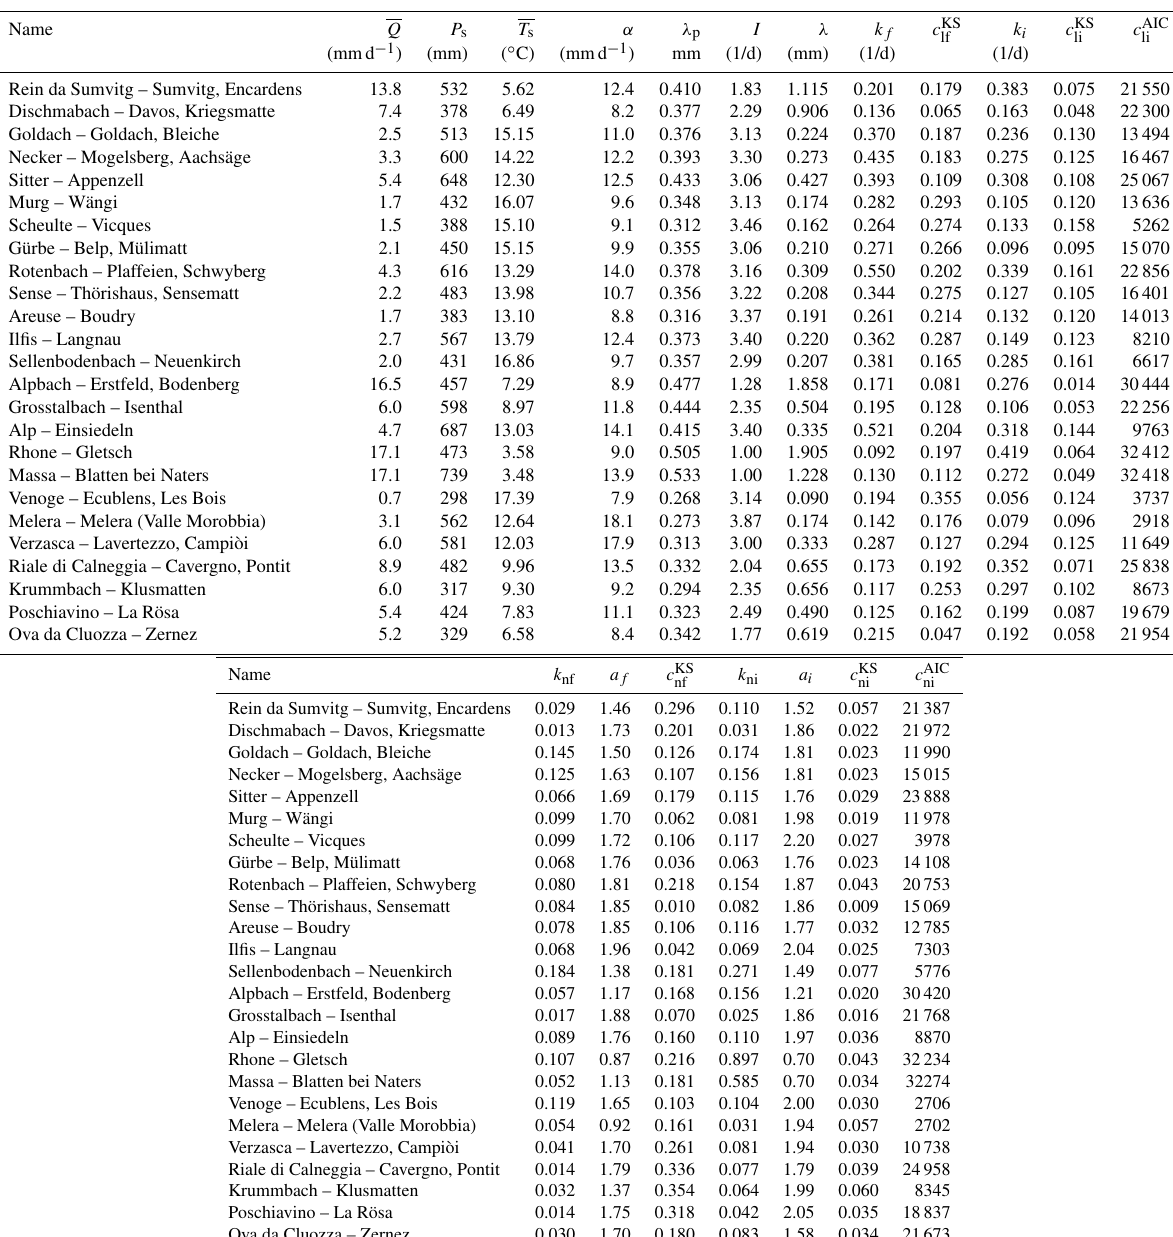
Table 2. Parameter values and performance indicators for all the catchments for summer with linear model and forward estimation, summer linear model and inverse estimation, summer nonlinear model and forward estimation, winter nonlinear model and inverse estimation and winter linear model and forward estimation. Q stands for the mean observed discharge, P s the mean total precipitation during summer, T s the mean temperature during summer, I for interception depth and c KS for the Kolmogorov–Smirnov distance. The indices stand for f , forward estimation; i , inverse estimation; l , linear model; n , nonlinear